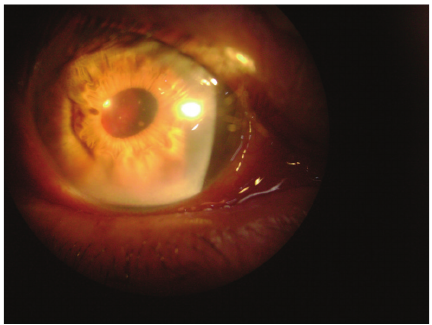
Figure 1: Presence of acute bleeding in the posterior chamber involving the visual axis.